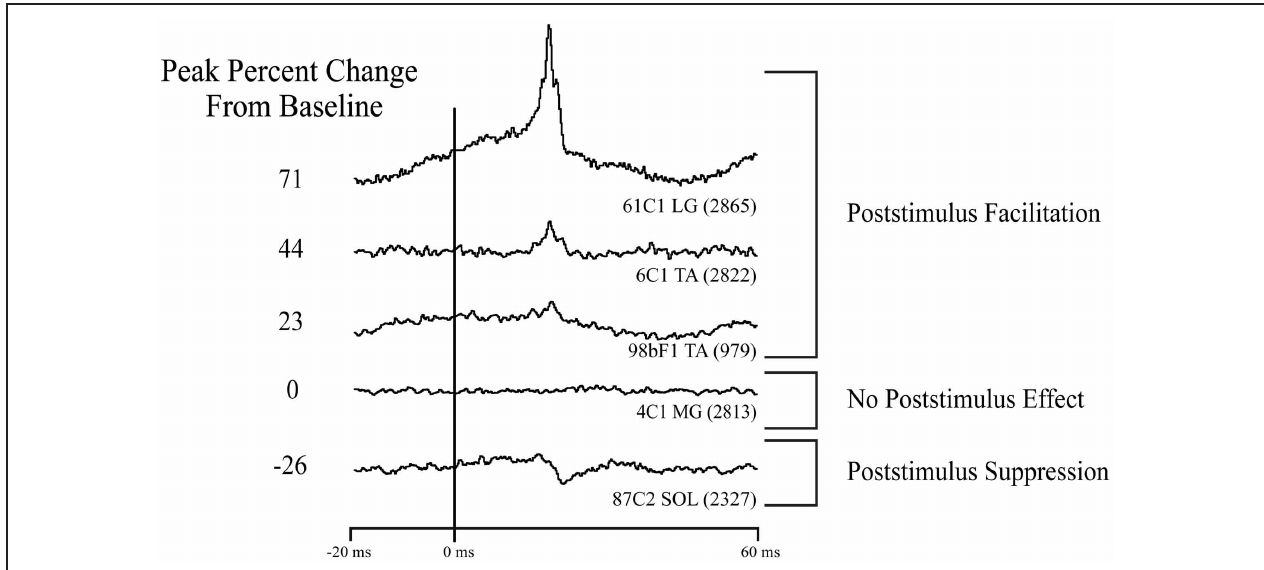
FIGURE 2 | Types of effects observed in stimulus triggered averages of ankle muscle EMG activity. Column on left: magnitude of the primary poststimulus facilitation (PStF) or poststimulus suppression